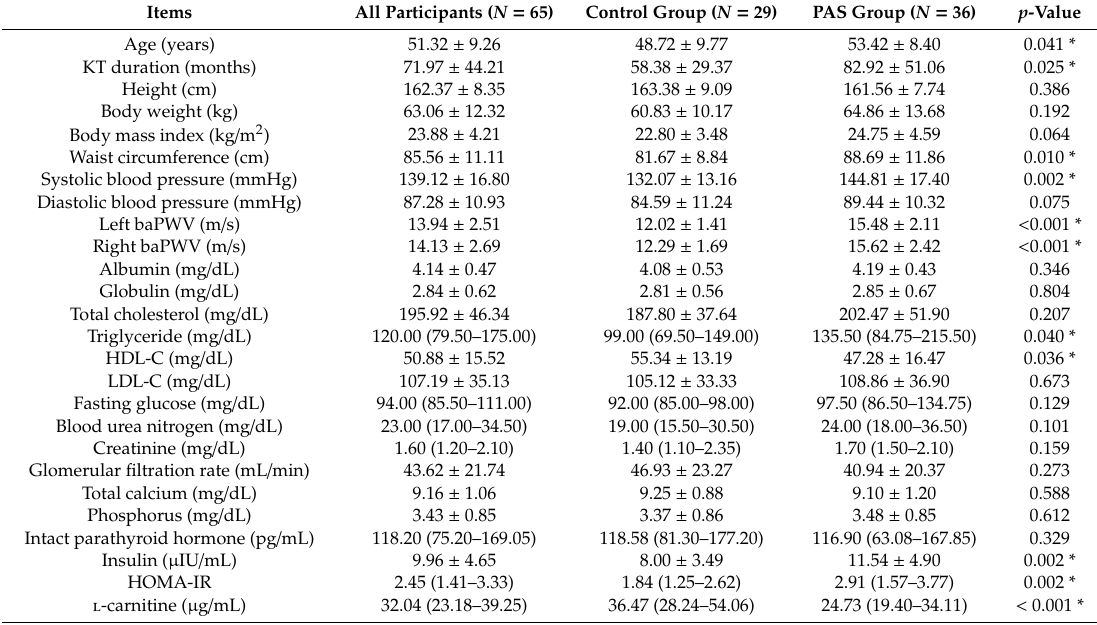
Table 1. Clinical variables of the 65 renal transplant recipients with or without peripheral arterial sti ff ness.